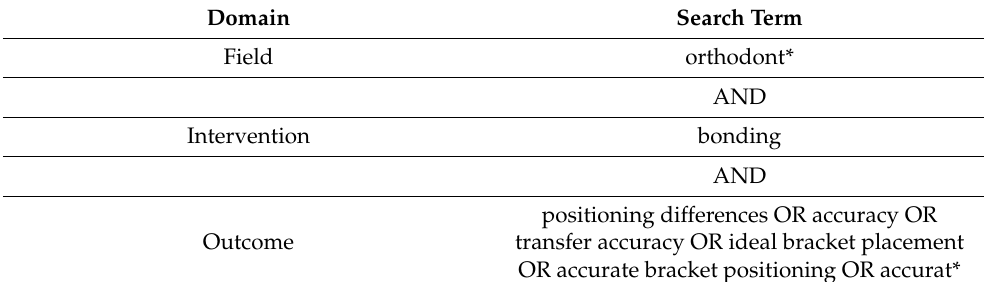
Table 1. Concept of the search